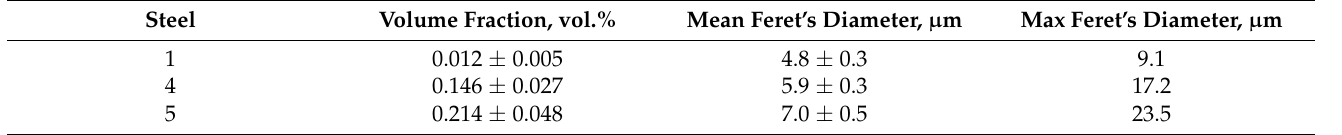
Table 7. Assessment of Steels NMIs